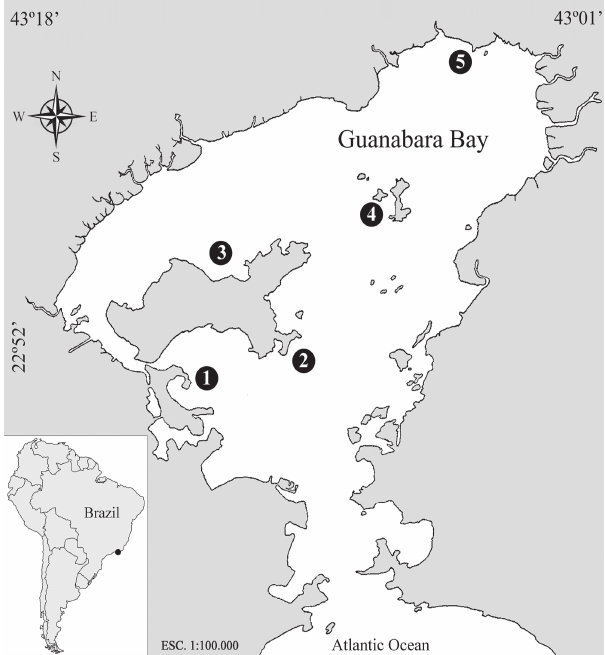
Fig. 1. Guanabara Bay, Rio de Janeiro, Southeastern Brazil, indicating the sampling sites: 1- Bancários, 2 - Magé, 3 - Paquetá Island, 4 - Ilha do Fundão, 5 - central